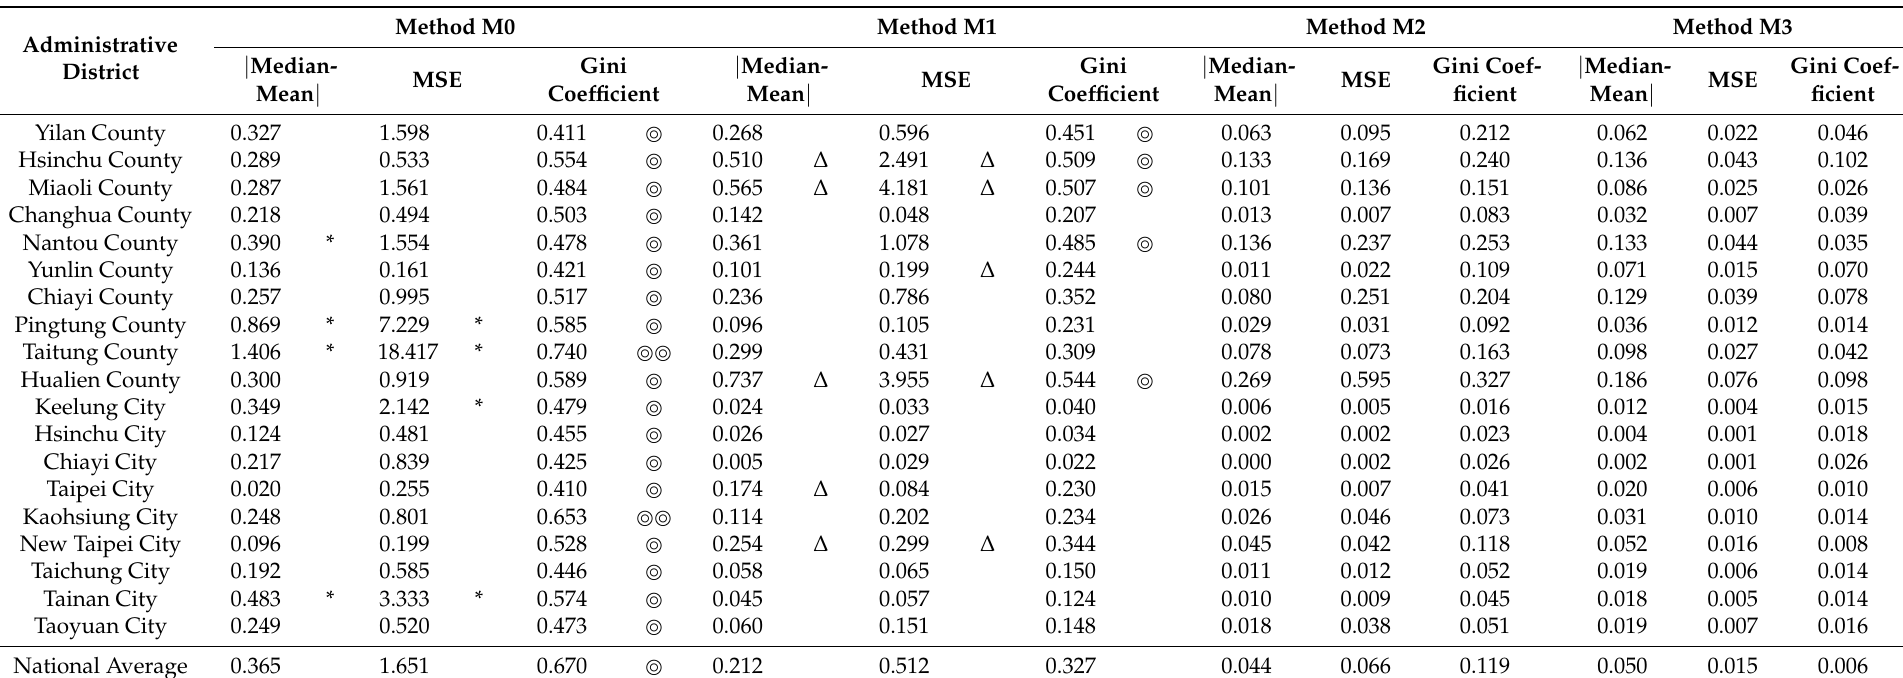
Table 7. Measures of geographic inequity of community care resources by methods M0–M3 (county